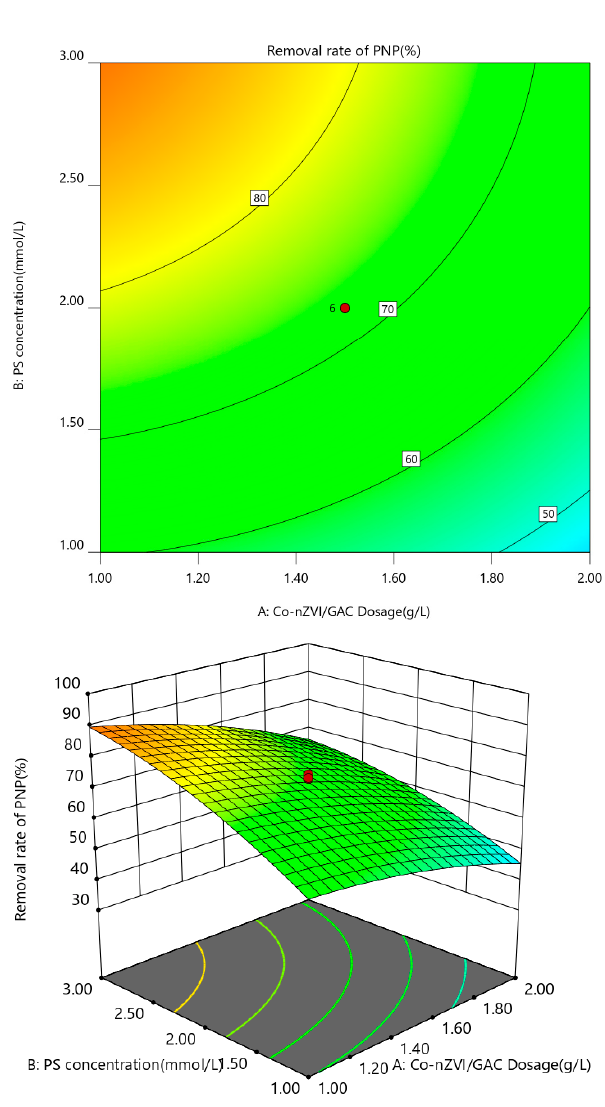
Figure 7. Response surface of Co-nZVI/GAC dosing and PS concentration.